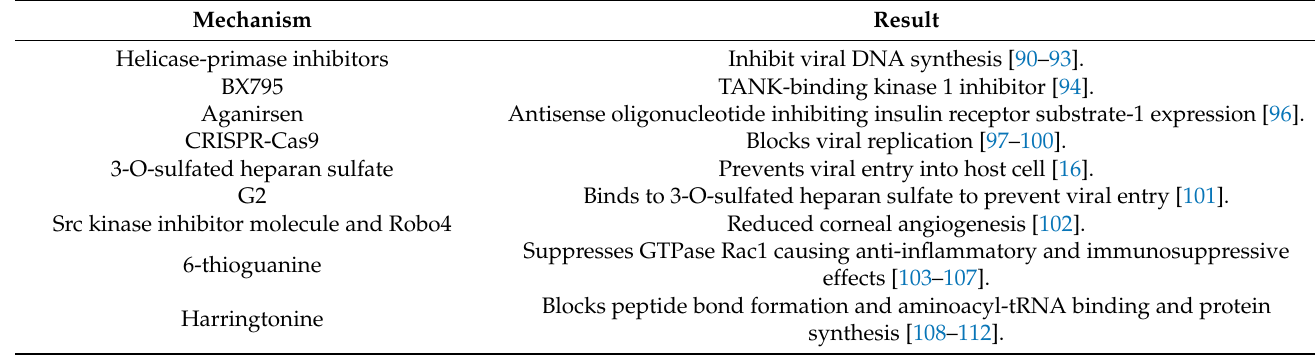
Table 3. Summary of potential therapeutic options for HSV